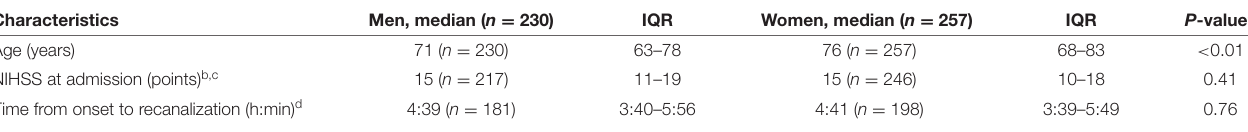
TABLE 1 | Clinical characteristics by sex.